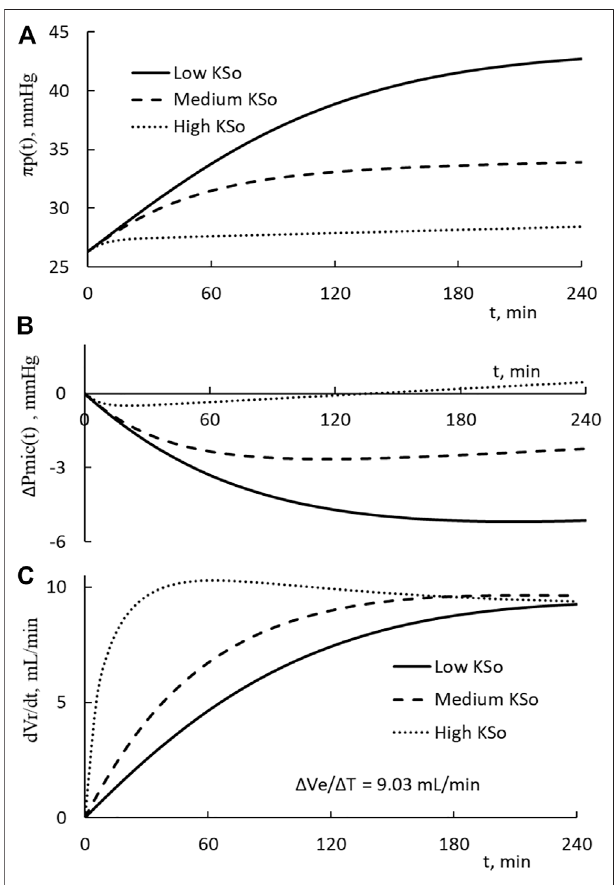
FIGURE4|(A) TemporalincreasesontheplasmaCOP forpatients with low, medium, and high fi ltration coef fi cient KSo. The HD is performed with